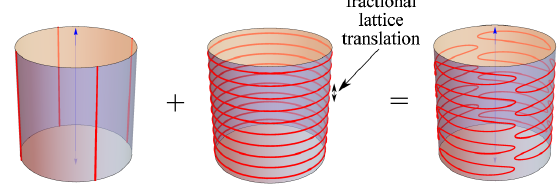
FIG. 6. Illustration for the two equivalent surface states corresponding to a fourfold screw. The equivalence of the two can be established by noting that their sum can be deformed to a trivial state while preserving the screw